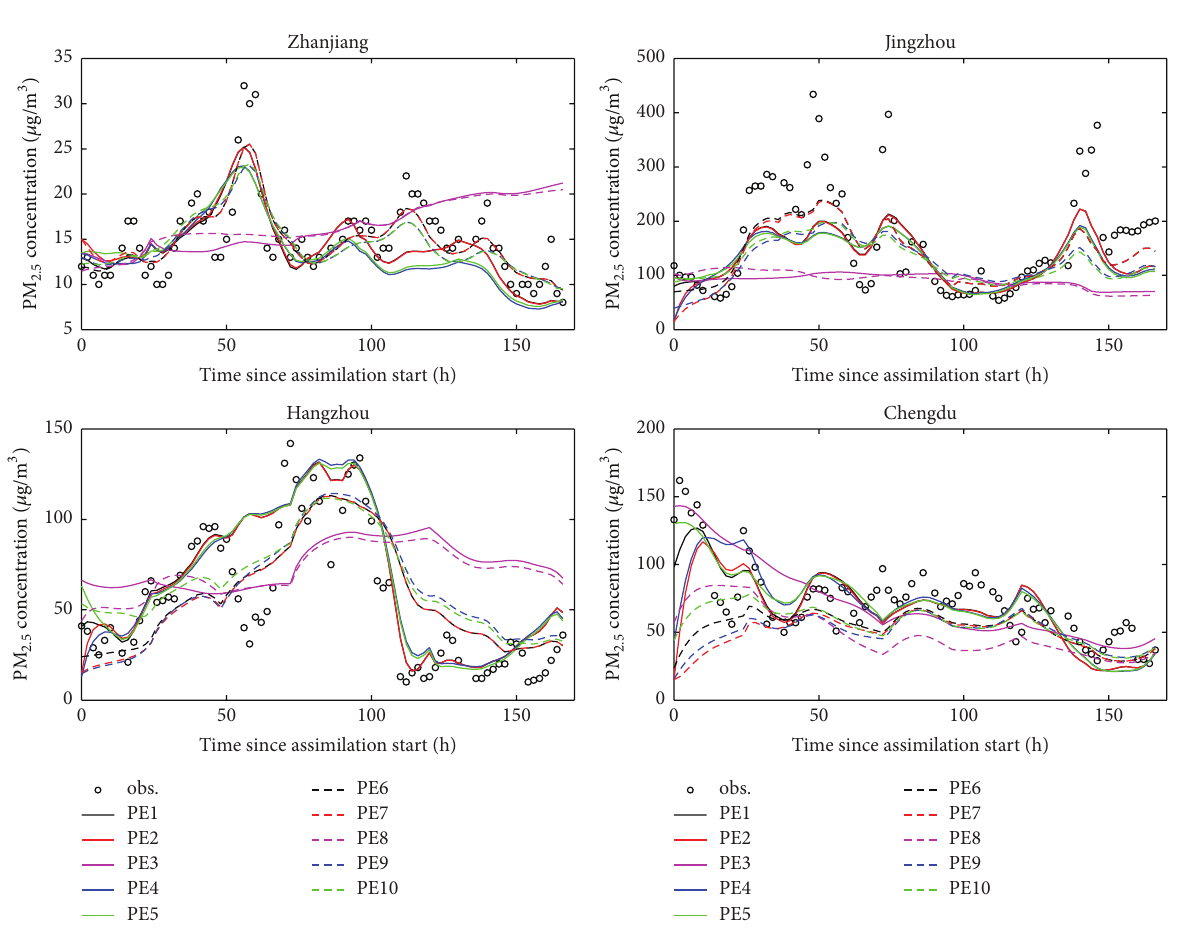
Figure 4: The time-varying PM 2.5 concentrations of four representative cities.